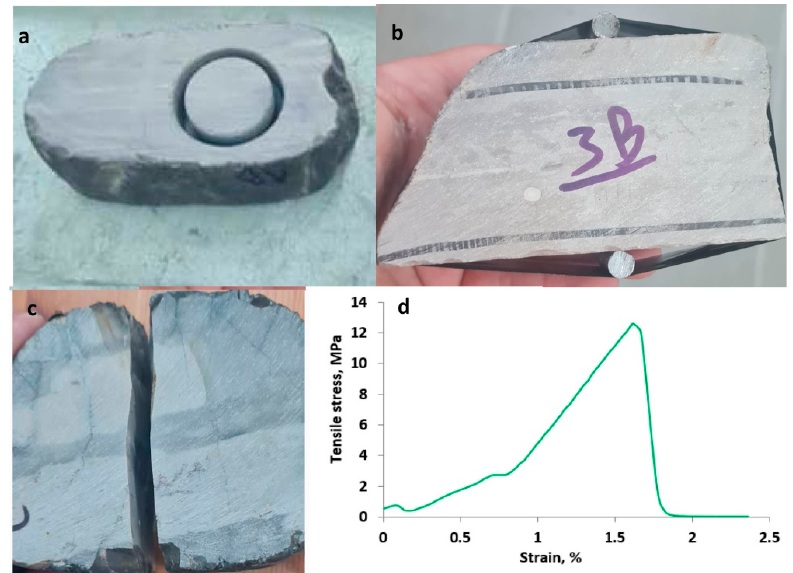
Figure 9. ( a ) The ∼ 1.5 cm deep borehole in chert rock sample after one-hour drilling; ( b ) the typical assemblage of the chert rock samples prepared for modified Brazilian test; ( c ) the typical shape of the chert sample split between two steel pins; ( d ) the typical strain-stress diagram.